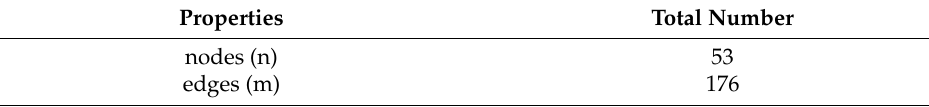
Table 1. Dataset: Summary